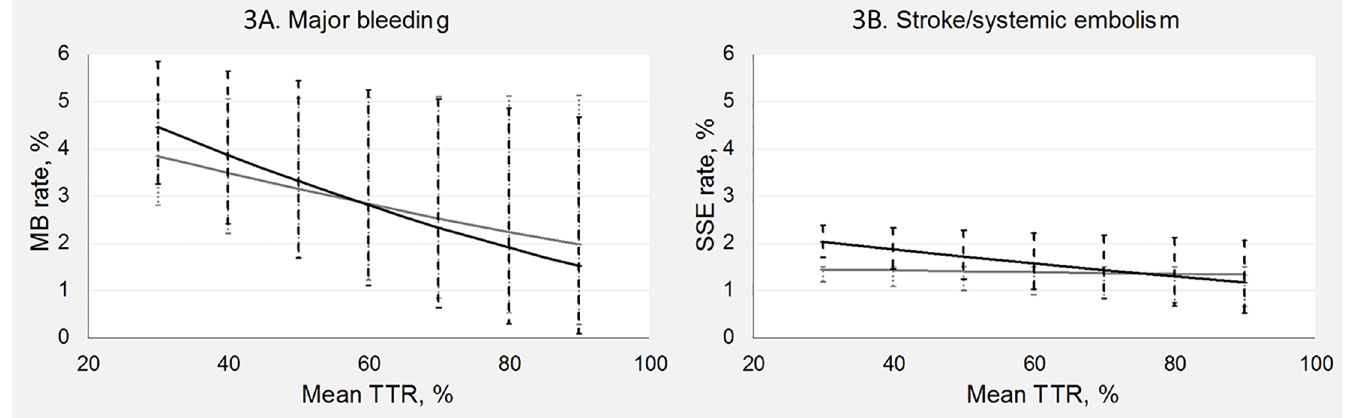
Fig 3. Association between mean time in therapeutic range and rate of major bleeding and stroke/systemic embolism, predicted from uni- and multivariable meta-regressions. Predicted rates of major bleedingand stroke/systemic embolismbasedon meta-regression with mean TTR as predictor basedon univariable(black lines) and multivariable(grey lines) meta-regression.For the predictedrates based on multivariable meta-regression, the unweighted mean values from studies were used for age, proportionwith prior stroke/transient ischemic attack, and proportionfemales. Vertical lines indicateestimated 95% confidenceintervals. MB: Major bleeding,SSE: Stroke/systemic embolism, TTR: Time in therapeuticrange.